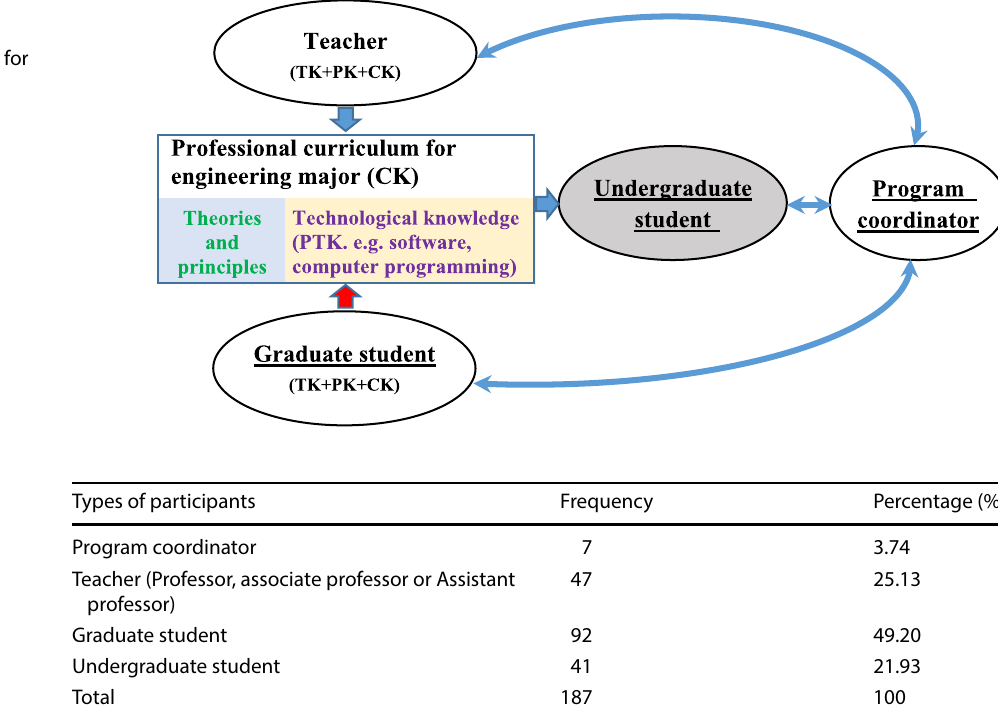
Table 1 Position held by